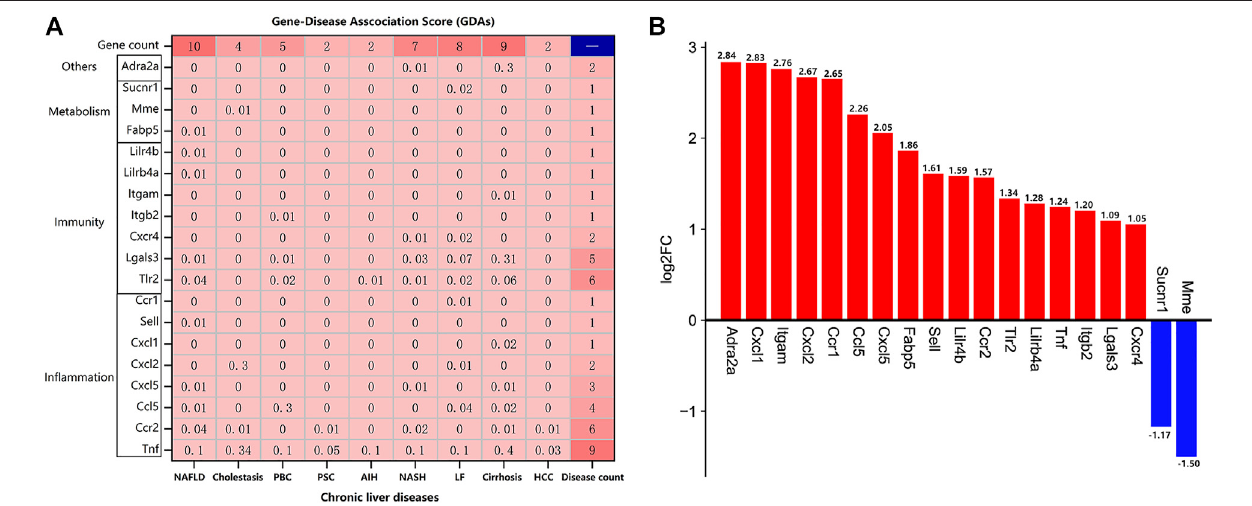
FIGURE 6 | Identi fi cation of potential target genes of TDF for direct alleviation of chronic liver diseases (CLDs). (A) The gene – disease association (GDAs) score between the 19 potential target genes and nine CLDs. Gene count: the number of genes associated with a certain CLD; disease count: the number of CLDs associated with the corresponding gene. (B) The log2FC of the 19 potential target genes using RNA-seq data.